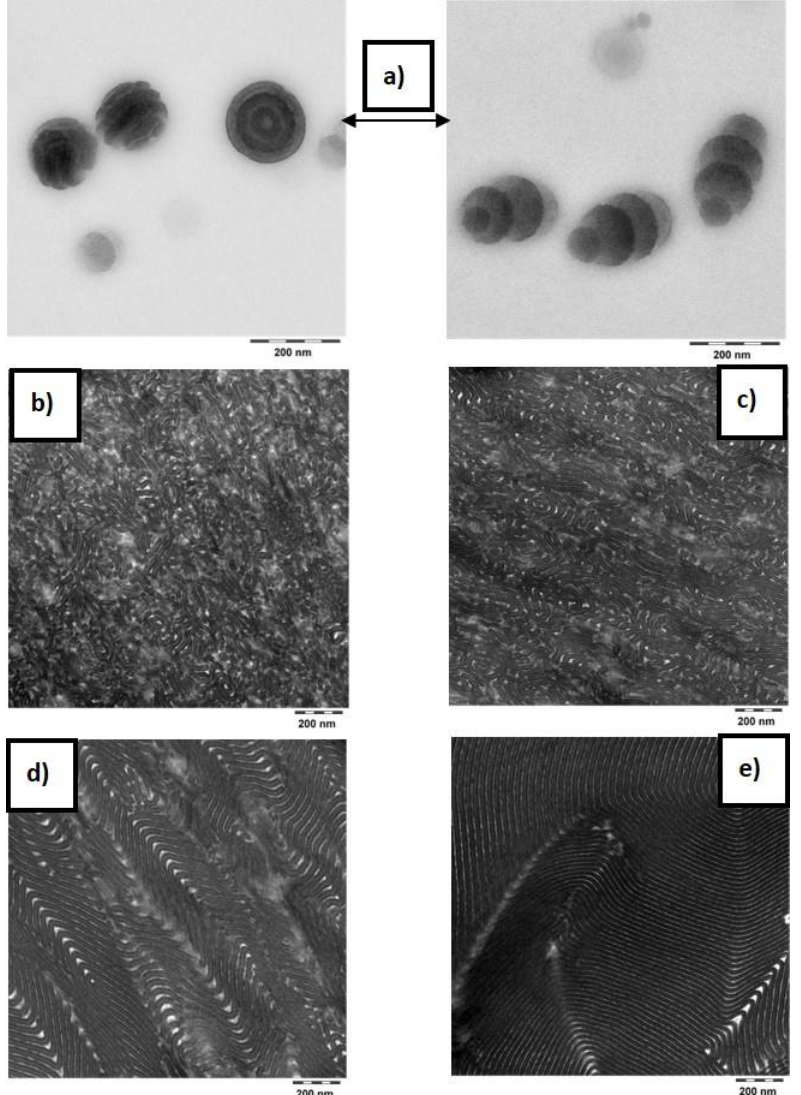
Figure 6. Transmission electron microscopy (TEM) images of the sample p(St50/2EHA50) stained with RuO 4 . ( a ) Particles dispersion embedded in hydroxyethyl cellulose; ( b ) latex film dried at room temperature; ( c ) latex film dried at room temperature and annealed at 100 °C for 30 min; ( d ) latex film dried at room temperature and annealed at 100 °C for 96 h; and ( e ) film cast from THF solution. Scale bar = 200 nm.